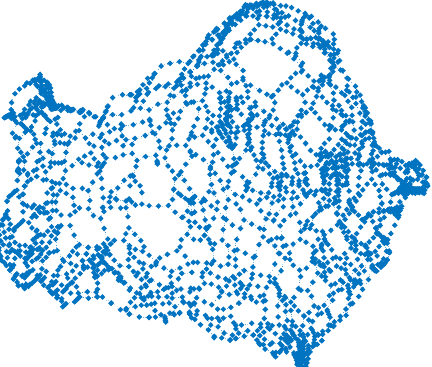
Figure 4. The road network of the state of Minnesota was chosen as a case study in this paper. It includes 2640 nodes representing the road intersections and 3302 links representing the roads.